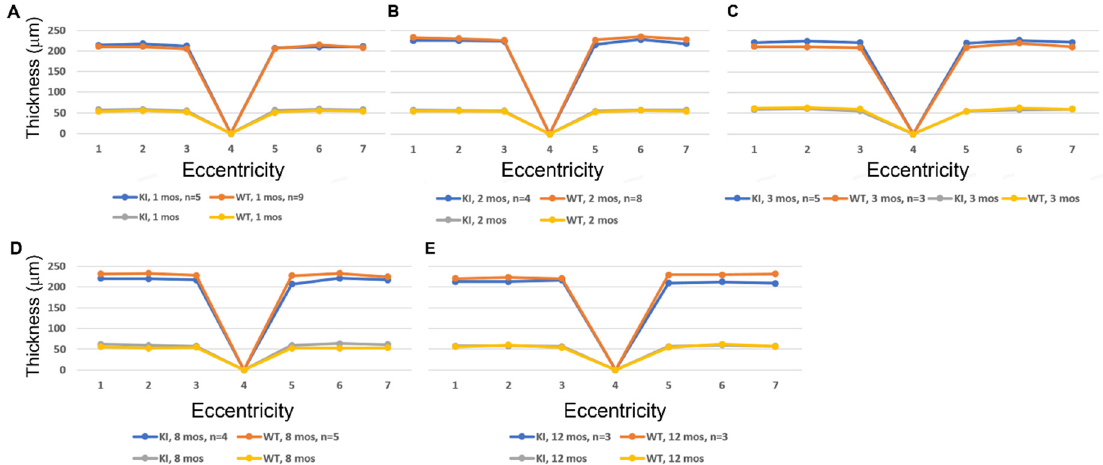
Figure 2. Representative averaged SD-OCT images of retinas from (left panels: A , C , E , G , I ) 1-, 2-, 3-, 8- and 12-months (mos) old wild type (WT), and (right panels: B , D , F , H , J ) 1-, 2-, 3-, 8-, and 12-months old Dhdds K42E/K42E mice. Abbreviations: IPL, inner plexiform layer; ONL, outer nuclear layer; ROS, rod outer segment layer. No changes were observed at any age in retinas of Dhdds K42E/K42E mice compared to WT mice.